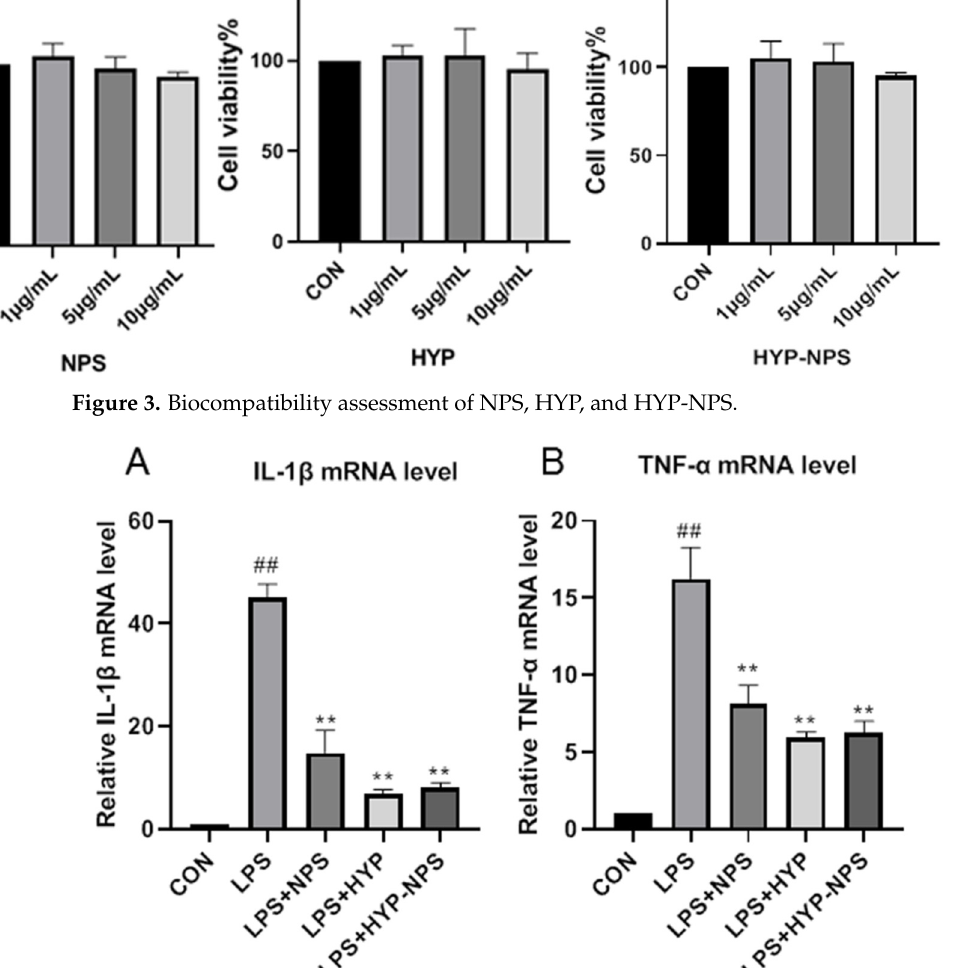
Figure 4. Effects of HYP (5 μ g/mL), LPS + NPS (25 μ g/mL), and LPS + NPS-HYP (25 μ g/mL) on the mRNA expressions of IL-1 β ( A ) and TNF- α ( B ), responding to LPS (1 μ g/mL)-treated RAW264.7 cells for 24 h in vitro. Values are mean ± SD. ## p < 0.01 vs. control, ** p < 0.01 vs. LPS. n = 6 for each